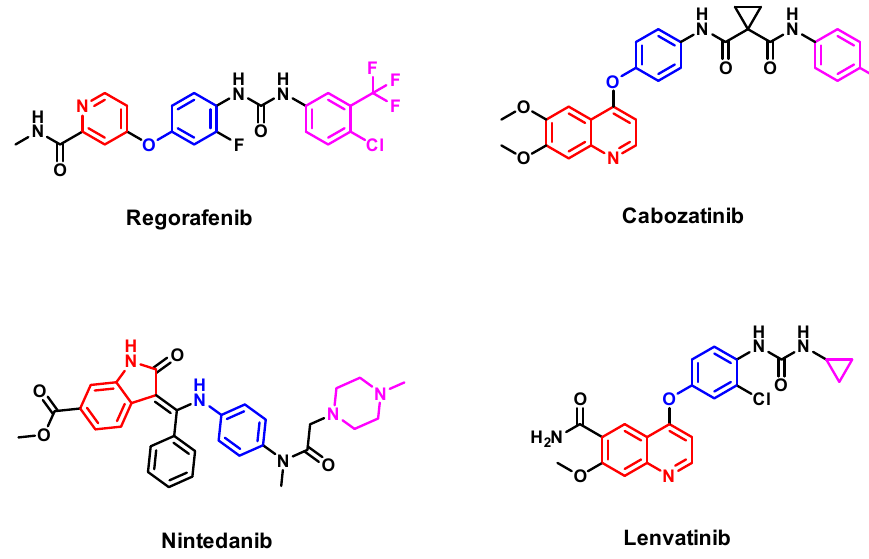
Figure 2. Pharmacophoric features of the next-generation VEGFR-2 inhibitors.